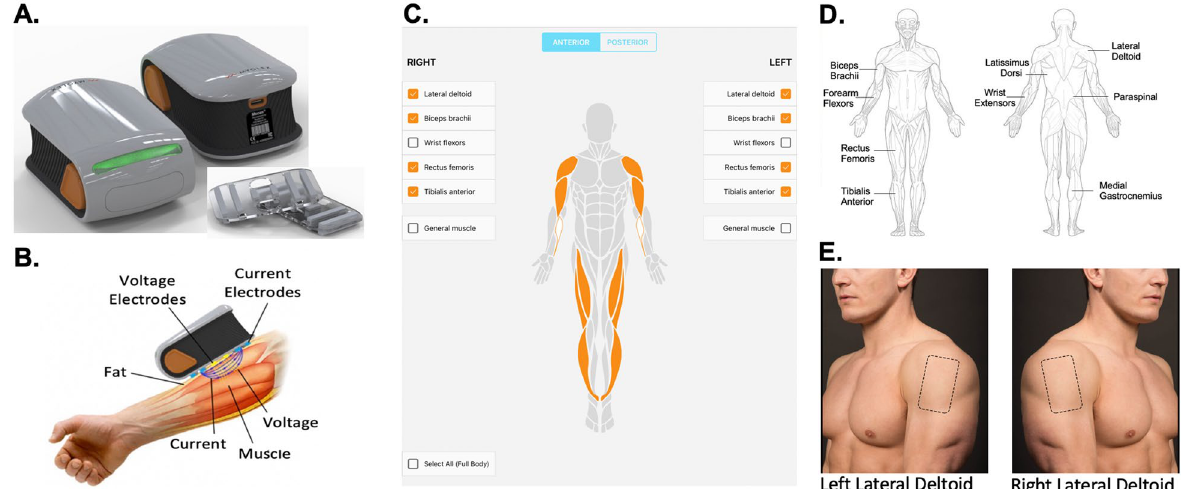
Figure 1. EIM experimental setup. ( A ) Handheld mScan EIM device, which is connected via Bluetooth to an iPad. EIM sensors are shown on the bottom right. The mScan data acquisition app is also installed on the iPad. An additional iPad is used for video conferencing enabling study staff to monitor data acquisition and the participants in real time. ( B ) The EIM device sends electrical impulses from the skin towards deeper muscle tissue. The integrity of underlying muscle tissue will impact the propagation of electrical impulses between electrodes. ( C ) Front page of the mScan app as displayed on the iPad and viewable by the individual acquiring the EIM data as well as the study staff remotely connected to the iPad via Zoom. ( D ) In this study, multiple anterior and posterior muscle groups were evaluated in each study participant. ( E ) Instruction provided on the mScan app notifying the individual acquiring the data where to place the EIM device on the FOP patient or healthy control subject. Example is shown for the left and right lateral deltoid. Similar instructions and images were displayed for other muscle groups evaluated during the virtual study.